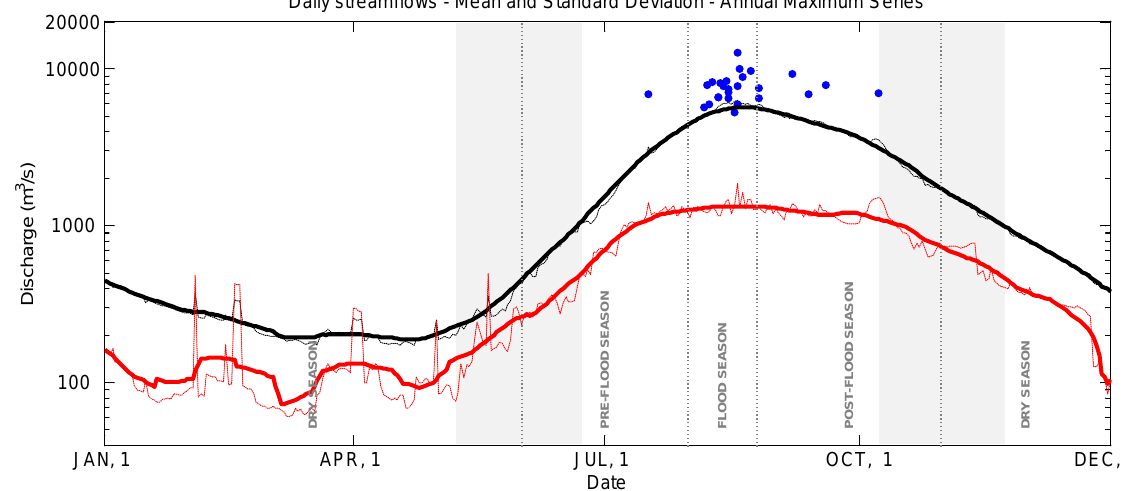
Fig. 2. Mean daily streamflow (black thin dotted line) and 30-day running mean (black thick line); standard deviation of daily streamflows (red thin dotted line) and a 30-day running mean (red thick line) as a function of the day of the year; annual maximum series are reported as blue dots; the four seasons considered in the study are also illustrated (grey shaded areas represent the time intervals considered in the sensitivity analysis, see Sect.